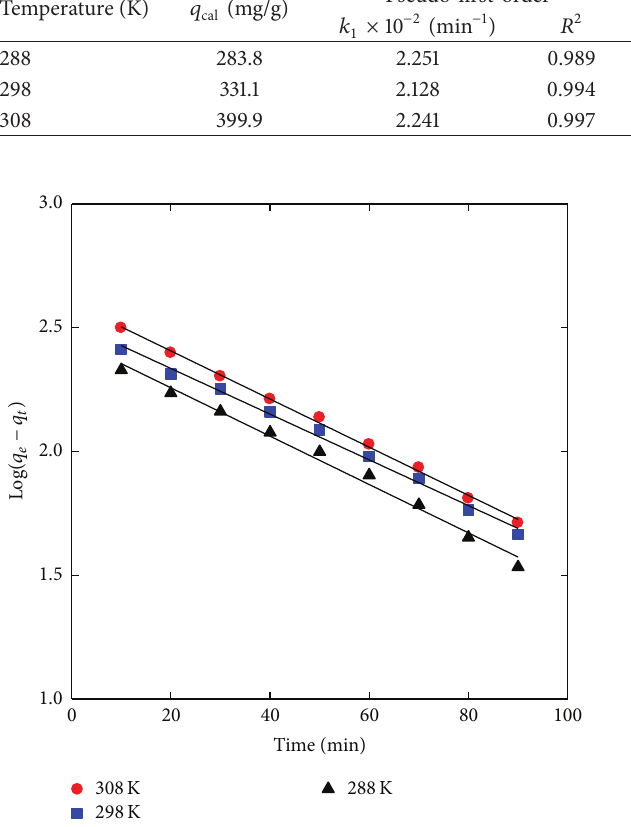
Figure 6: Linearized pseudo-second-order kinetic model of Garde- nia blue on TiO 2 thin film at different